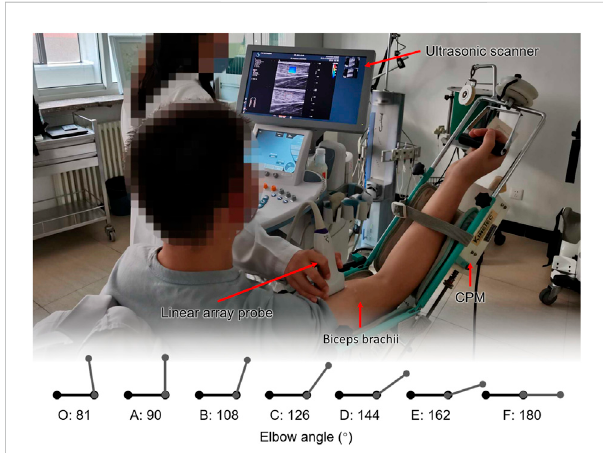
FIGURE 1 Participant and the experimental setting. Each participant took a sitting position. Their shoulder abducted 5 ° – 10 ° , fl exed 90 ° on the test side, and their upper limb was placed on the continuous passive motion(CPM)exerciser.Thestudystartedfromtheelbow fl exion at 100 ° , that is, 80 ° straightening (the angle between the forearm and the upper arm was 80 ° ) and ended at the extension